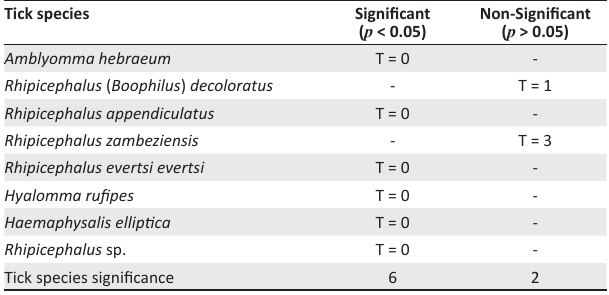
TABLE 2: The eight tick species collected according to their significance. Tick species Significant